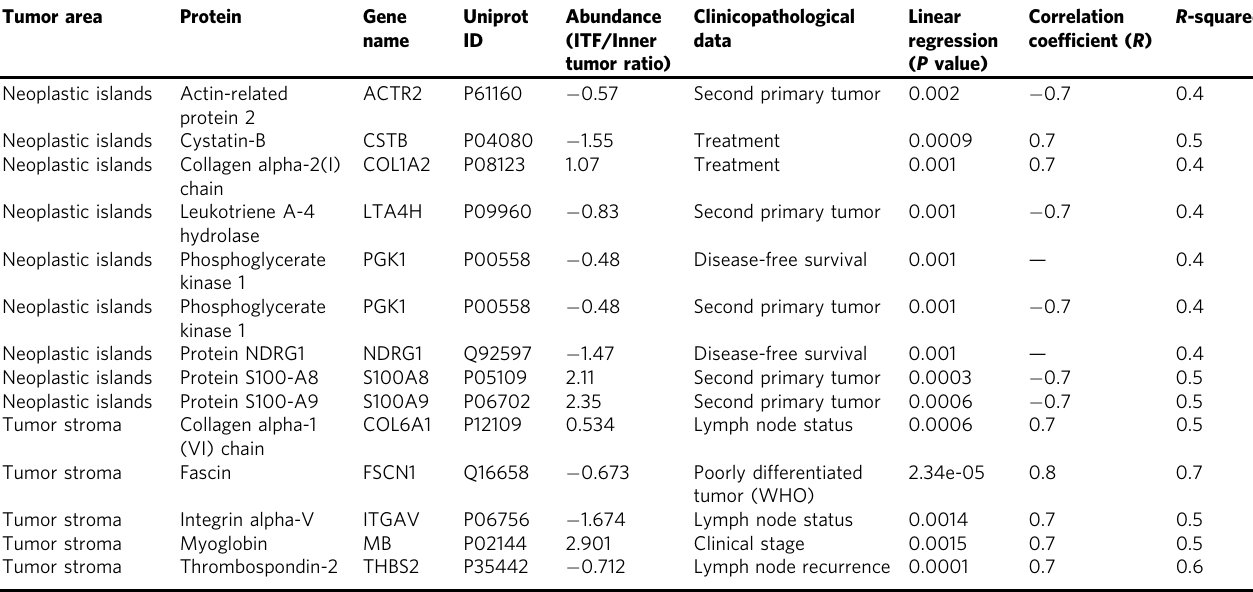
Table 1 Linear regression and correlation analyses of proteins with differential abundance in the invasive tumor front and inner tumor with clinicopathological variables of the cases used for LMD and LC-MS/MS